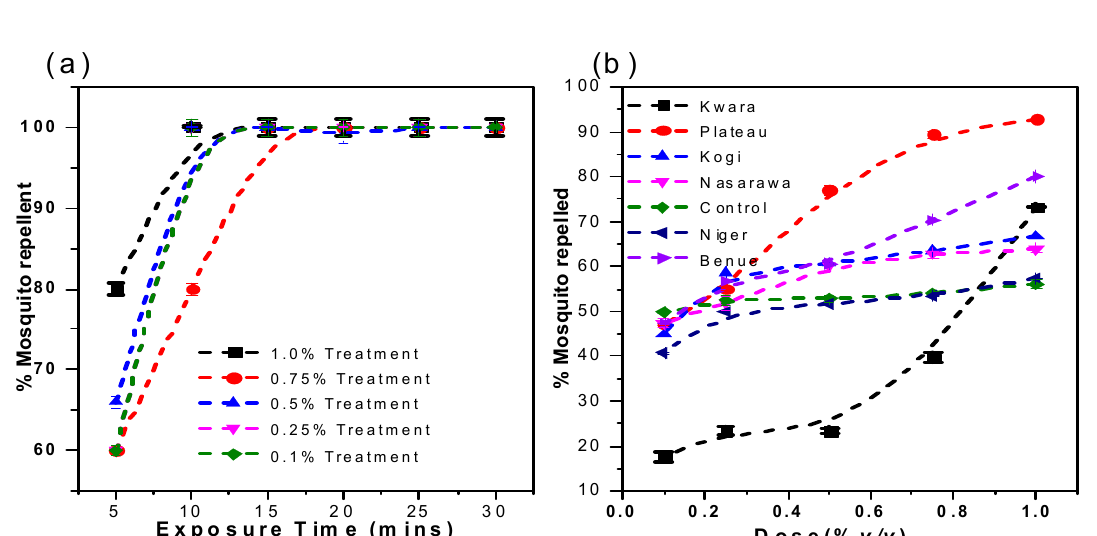
Figure 8. ( a ) % mosquito repellency every 5 min at an exposure time of 30 min to N, N-diethyl-3-methylbenzamide (DEET) and ( b ) Dose response mosquito repellency study of V. negundo essential oils obtained from the six states.